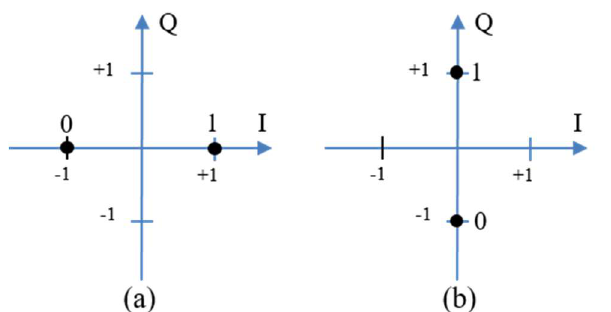
Figure 1. The three frame formats adopted in IEEE 802.11a / n / ac.